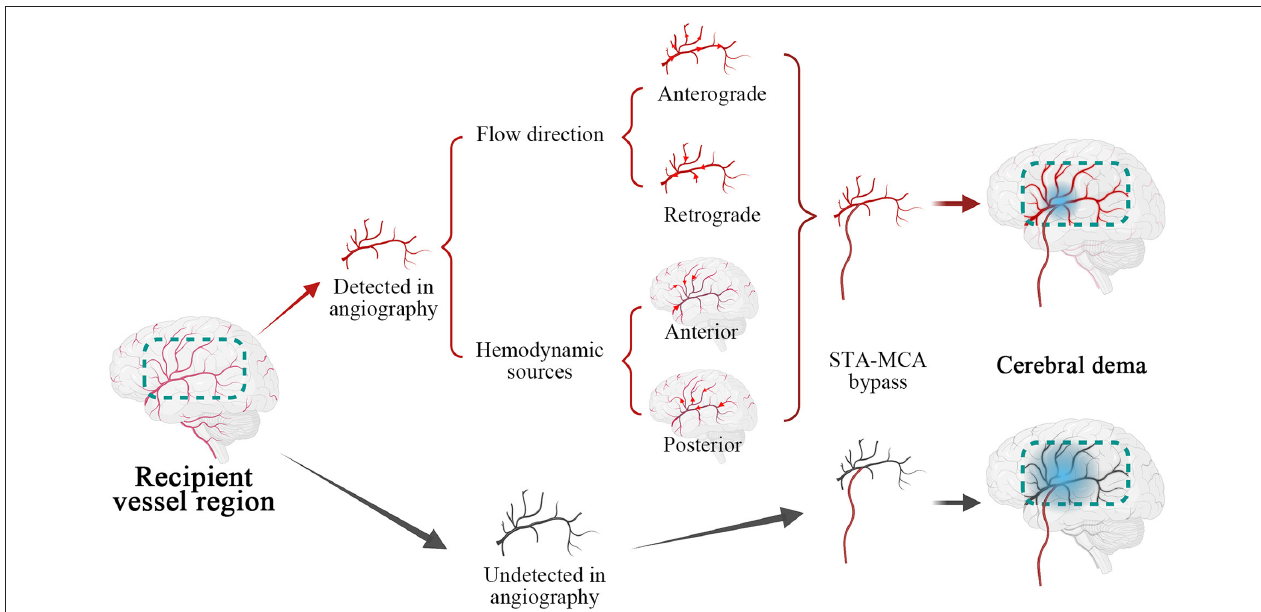
FIGURE 5 | Illustrations of recipient hemodynamic features on the cerebral edema. Marked by the dotted box in green, recipient vessel region was categorized as angiographic detected in red and undetected in black. The cortex vessels were applied with superficial temporal artery (STA)- middle cerebral artery (MCA) bypass, after subdivided by flow direction and hemodynamic sources, in which red arrows indicated specific directions of blood flow. Subsequently, the recipients with different hemodynamic characteristics developed cerebral edema implied by gradient blue circle and undetected recipients were prone to postoperative cerebral